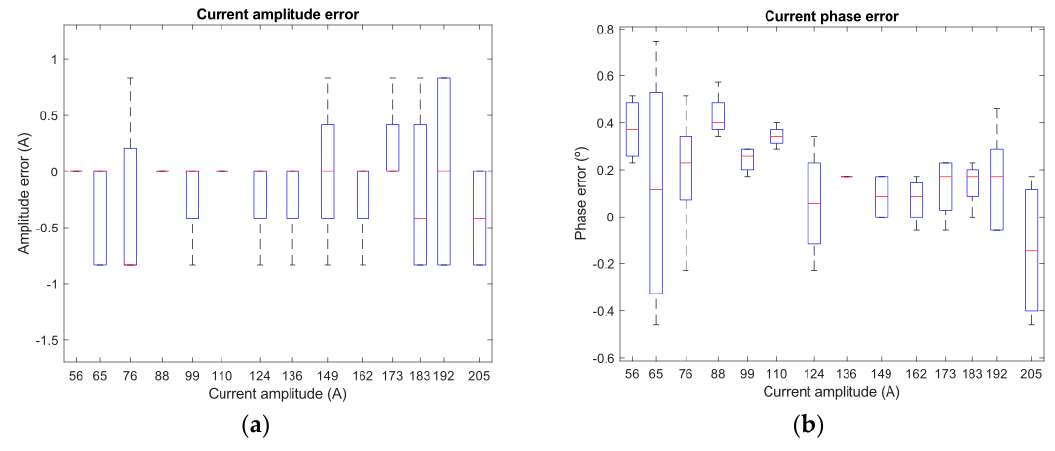
Figure 19. ( a ) Amplitude graph; and ( b ) phase graph.